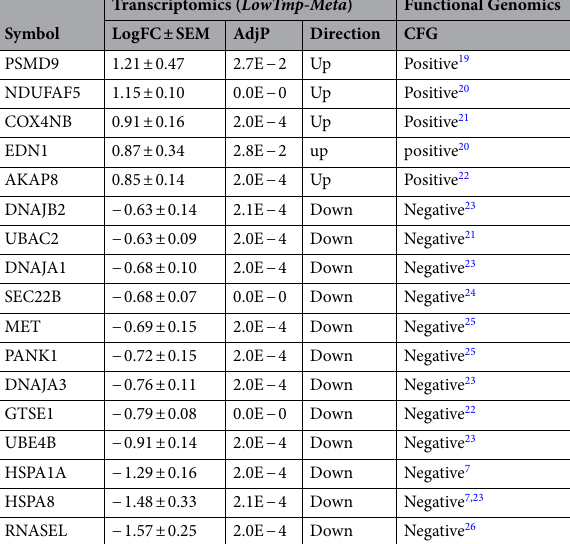
Table 2. Transcriptomic and functional genomic support for candidate mediators of low-temperature rescue of ΔF508-CFTR trafficking. Direction column shows the sign of differential expression in the LowTmp- Meta signature. The CFG column shows the sign of each gene’s net effect on CFTR trafficking based on the referenced study, i.e. positive indicates membership in the CFG + set, and negative indicates membership in CFG − . LogFC logarithm (base 2) of the fold change, SEM standard error of the mean, AdjP adjusted p -value, CFG CFTR Functional